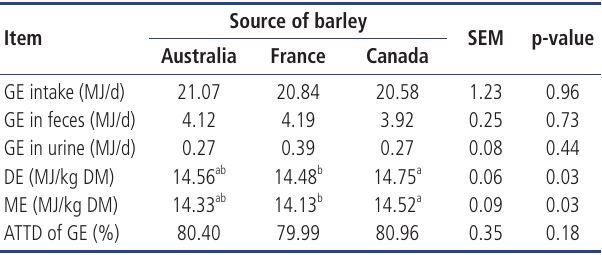
Table 5. Digestible energy (DE) and metabolizable energy (ME) as well as the appearance total tract digestibility (ATTD) of gross energy (GE) in barley obtained from different sources (Exp. 1) 1)